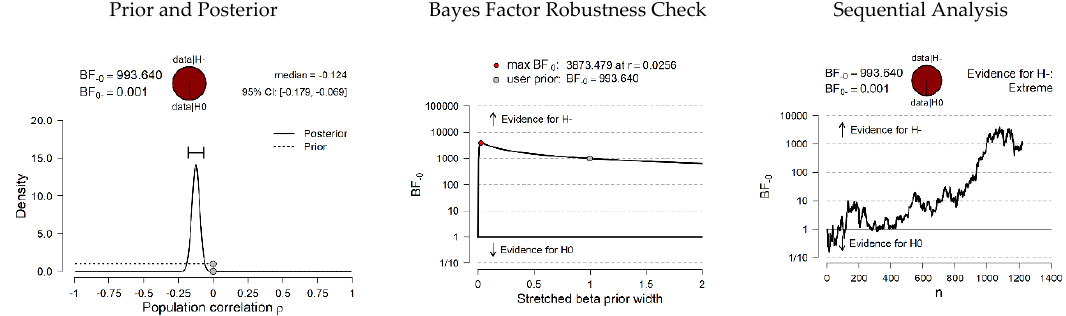
Figure 2. Bayesian correlation pairs. (Note: H 1 specifies that the correlation is negative).